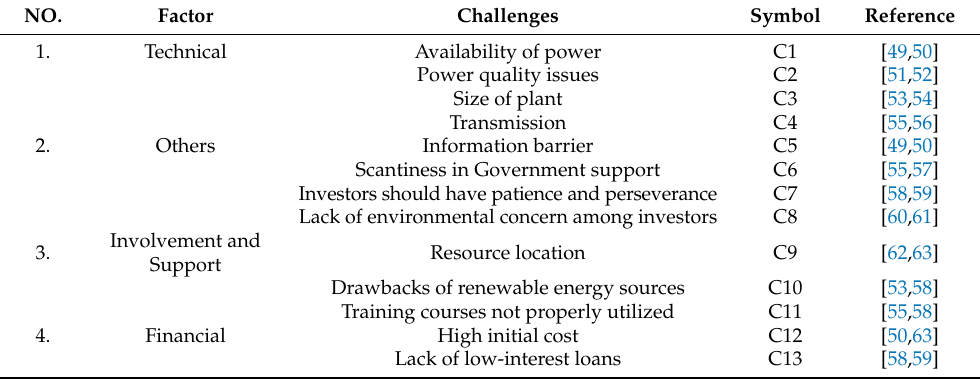
Table 1. Challenges for RE power generation. NO.